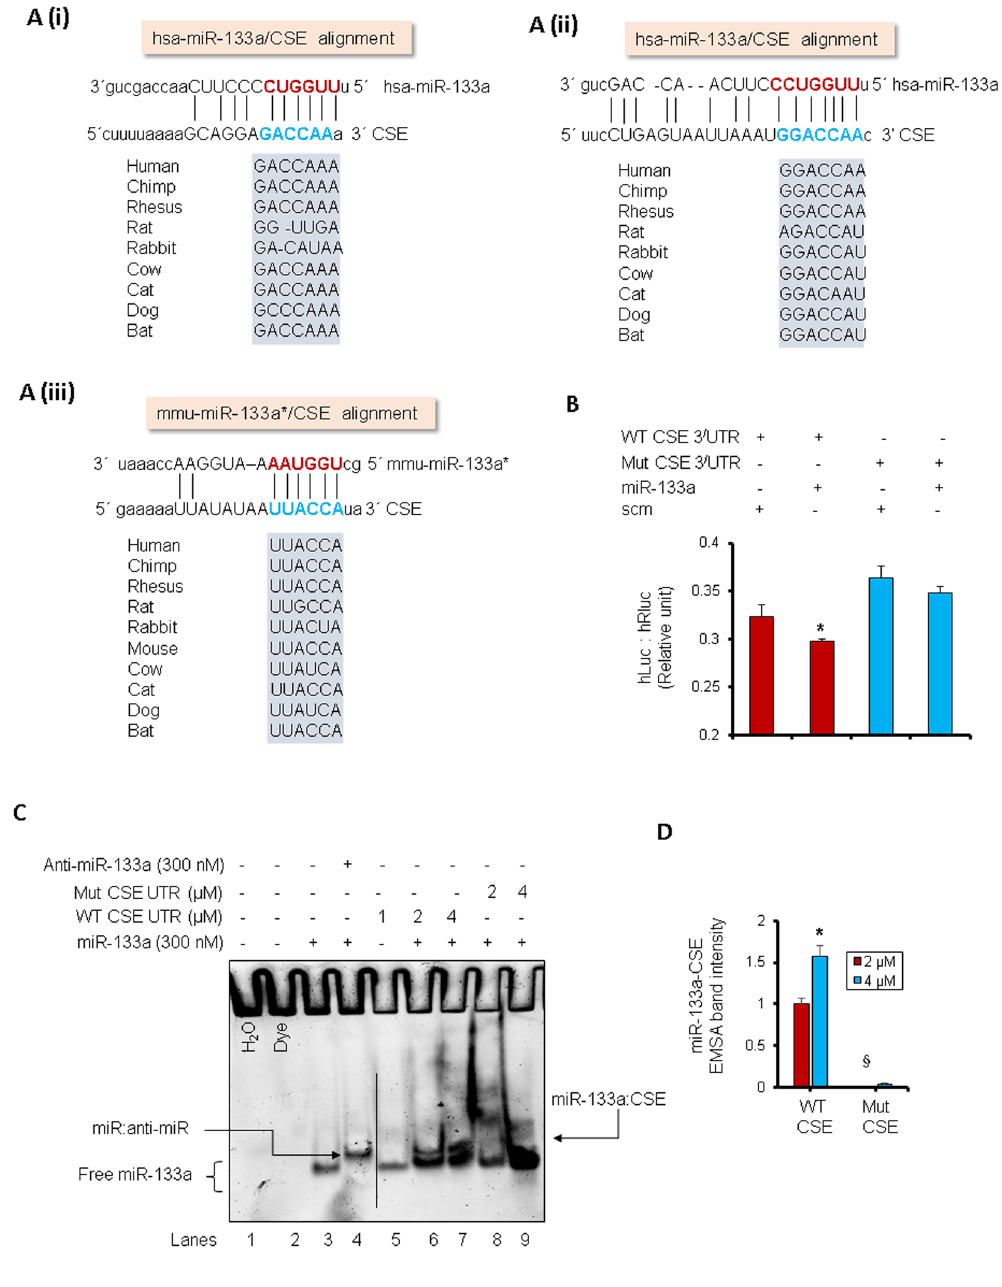
Figure 3. MiR-133a targets cystathionine gamma lyase (CSE). ( A ) ( i – iii ) Potential binding sites for miR-133a on 3 ′ UTR of CSE through in silico analysis. ( B ) Luciferase reporter assay showing the relative expression of luciferase activity (humanized luciferase, hLuc: humanized renilla luciferase, hRLuc) in miR-133a mimic-, or scrambled miRNA-treated HEK 293 cells co-transfected with either CSE 3 ′ UTR or mutant CSE 3 ′ UTR (miR-133a binding site is deleted in CSE 3 ′ UTR). hRLuc is an internal control for luciferase activity. Values are represented as mean ± SEM. p < 0.05 is considered statistically significant ( p = 0.04). N = 8. ( C ) miRNA-mRNA electrophoretic mobility shift assay showing binding of LNA miR-133a * probes with WT or mutant CSE 3 ′ UTR mRNA probes incubated with increasing concentration of 3 ′ UTRs (2 μ M or 4 μ M). ( D ) Quantification of miR-133a * -CSE band intensity in ‘ C ’ incubated with 2 μ M or 4 μ M of WT or mutant CSE promoter. Values are represented as mean ± SEM. p < 0.05 is considered statistically significant. N = 3. “ * ” represents statistically significant value for WT CSE at 4 μ M when compared to 2 μ M, “§” represents statistically significant value for mutant CSE when compared to the WT CSE at 2 μ